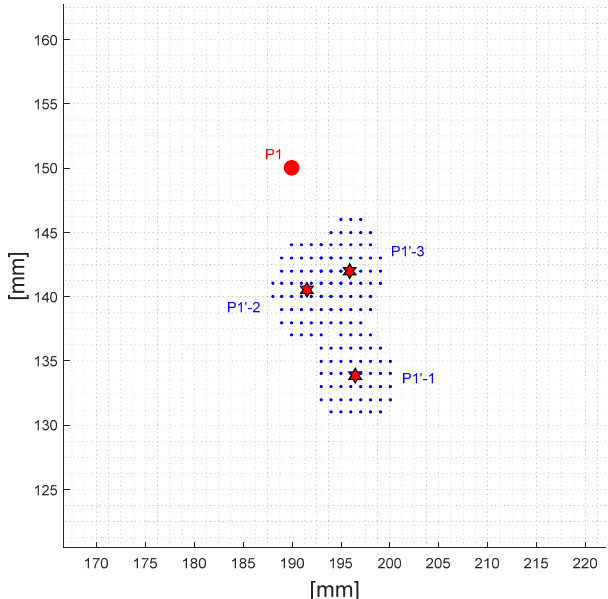
Figure 11. Zoom of results shown in Figures 8–10. The illustration reports the real impact point P1 (red circle), the detected impact points P1 ′ -1, P1 ′ -2, and P1 ′ -3 (red stars) together with the points 1% above the minimum of the error function (blue dots). Reproduced from [24].